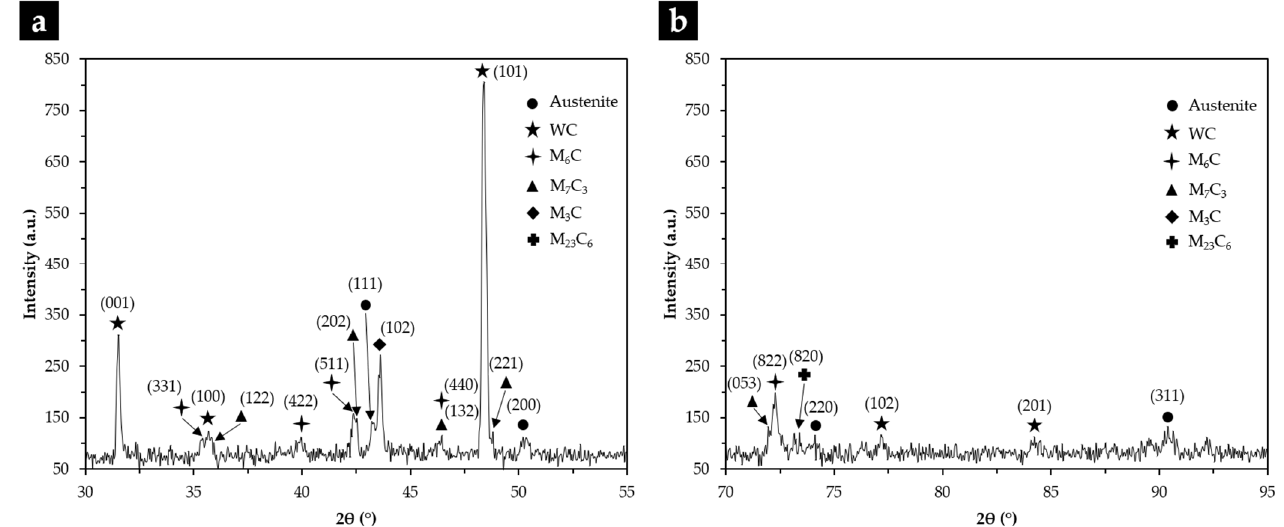
Figure 15. XRD patterns of the composite zone in the 2 θ range of 30–55° ( a ), and 70–95° ( b ).